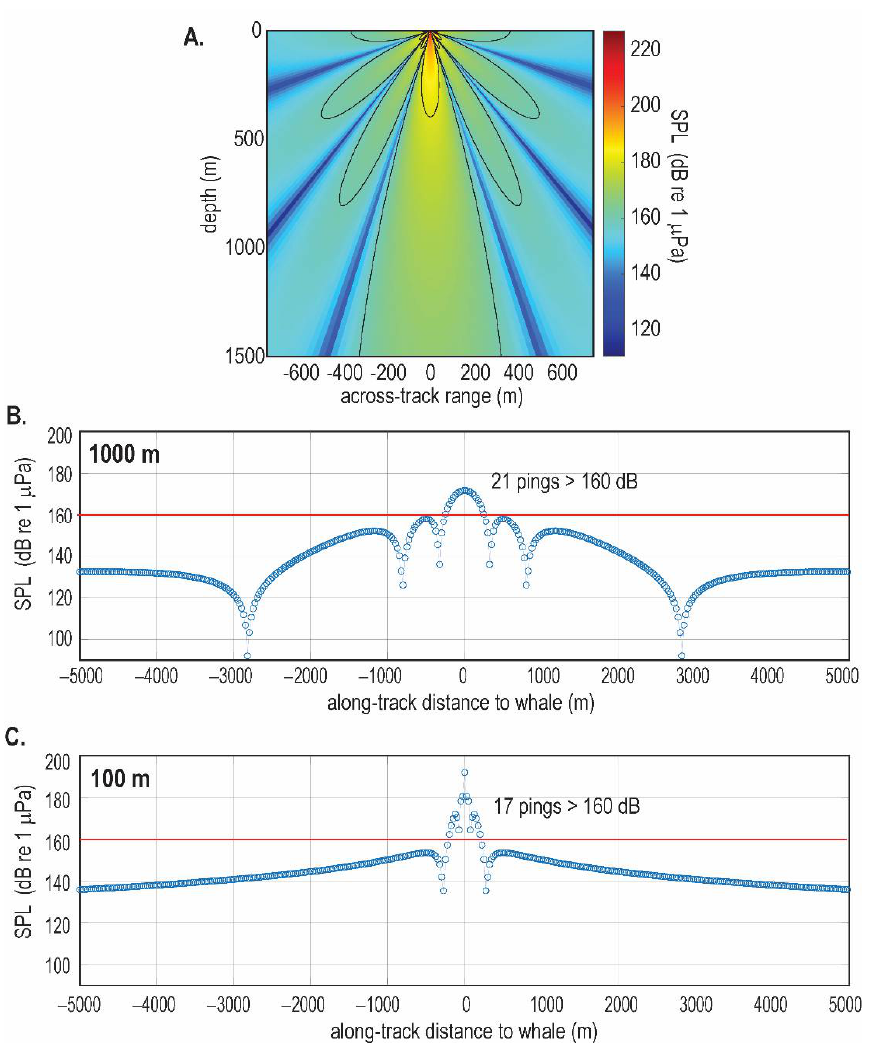
Figure 12. ( A ) SPL modeled for a Knudsen 3260 with 16 transducers operating at 4.5 kHz, with other parameters as given in the text. Panels ( B , C ) show the SPL received by a stationary animal at 1000 m and 100 m water depth, respectively, as the Knudsen 3260 hull-mounted SBP acquires data along a trackline with the geometry shown in Figure 10A inset. The red line is a reference level of 160 dB re 1 μPa.